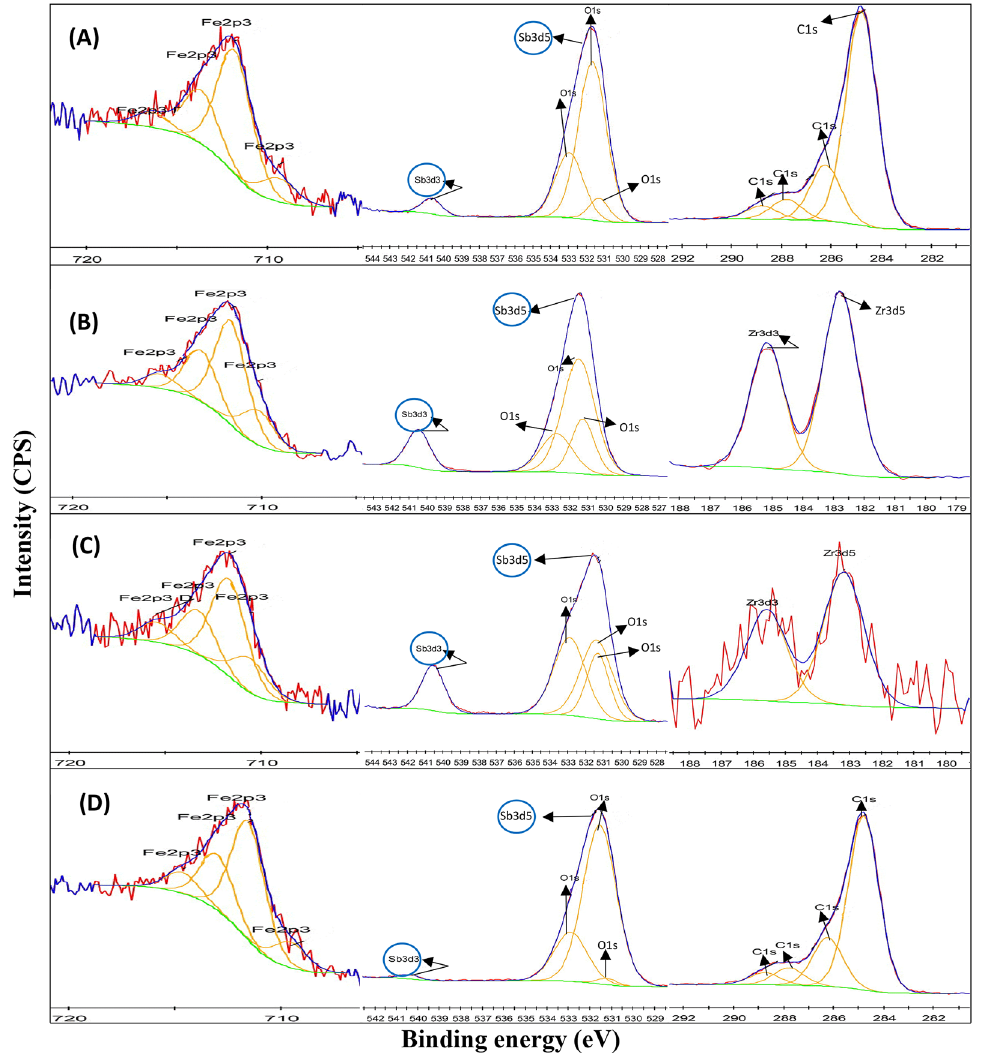
Figure 3. XPS expanded peaks of Sb-loaded BSBC (A) , ZrBSBC12.5 (B) , Zr-FeBSBC(1:20) (C) and FeBSBC (D) .